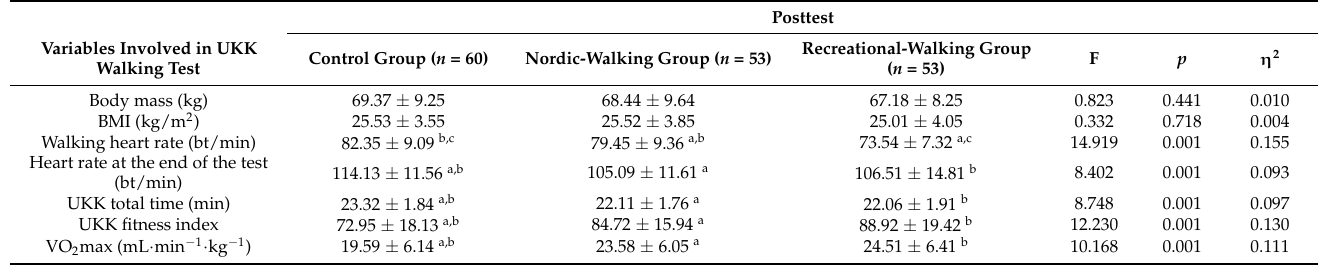
Table 3. ANOVA posttest results in terms of anthropometric measurement variables, heart rate, UKK walking test time and fitness index, and VO 2 max, with mean values